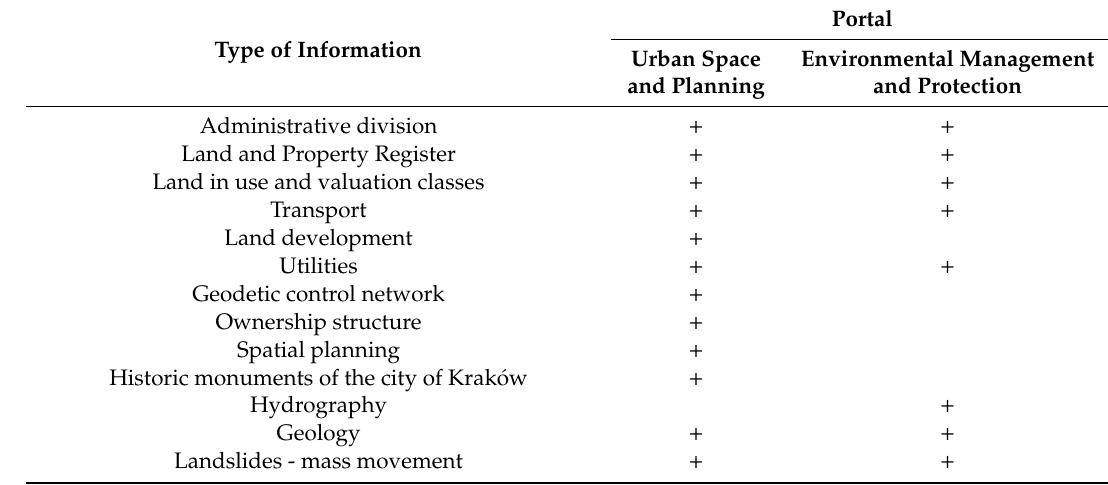
Table 1. Matrix of the data available in the Kraków Municipal Spatial Information System.